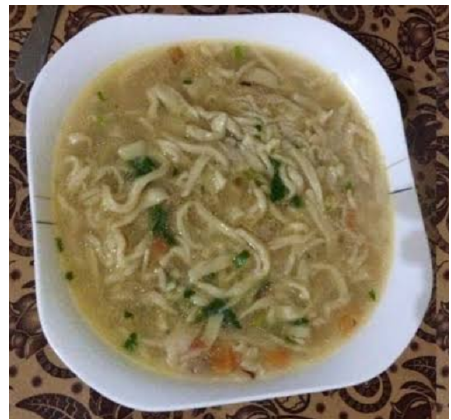
Figure 4. Traditional noodle soup known as Dawdoo, prepared in winter (photo courtesy of Asad Rahman).